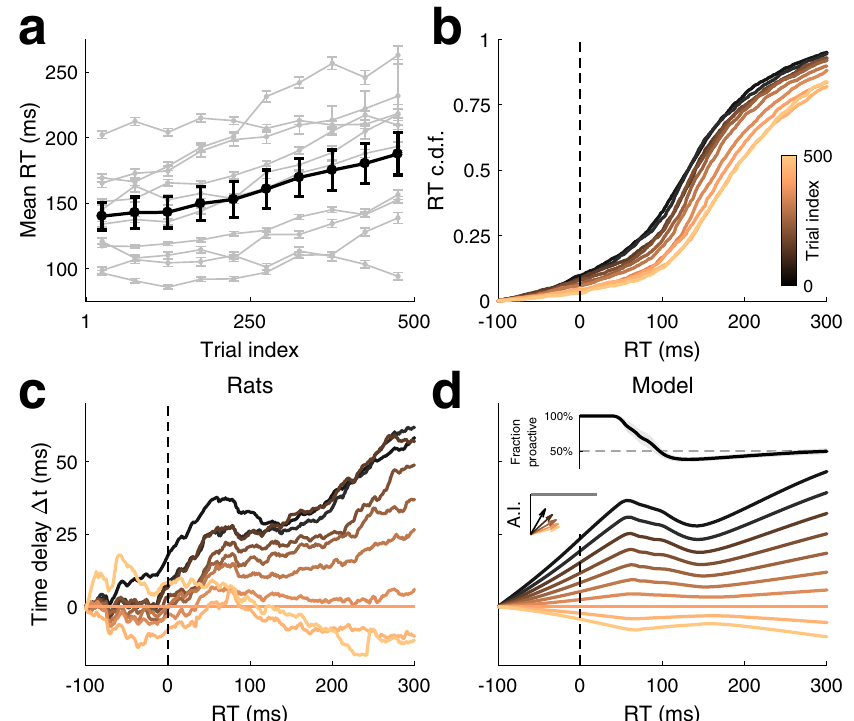
Fig. 6 Within session slowing of responses. a Mean RT as a function of trial position within the session. Thick black line: group average (Group 1, n = 10), thin gray lines: individual rats. Trials were grouped in 50 trial blocks. Error bars: s.e.m. b RT cumulative distribution for different trial blocks for an example animal (rat #14). Color code in panels ( b – d ) indicates trial block. Vertical dashed line in ( b – d ) indicates stimulus onset. c Time delay curves averaged across rats. Trial block 351 – 400 was taken as reference (i.e., corresponded to time delay Δ t = 0). d Time delay curves simulated using the PSIAM fi tted to the RTs for each animal, averaged across rats. Top inset: proportion of proactive vs reactive responses with RT as estimated by PSIAM for each animal, averaged across rats; shaded area: s.e.m. Left inset: sketch of the impact of trial index on AI ’ s drift. Source data are provided as a Source data fi